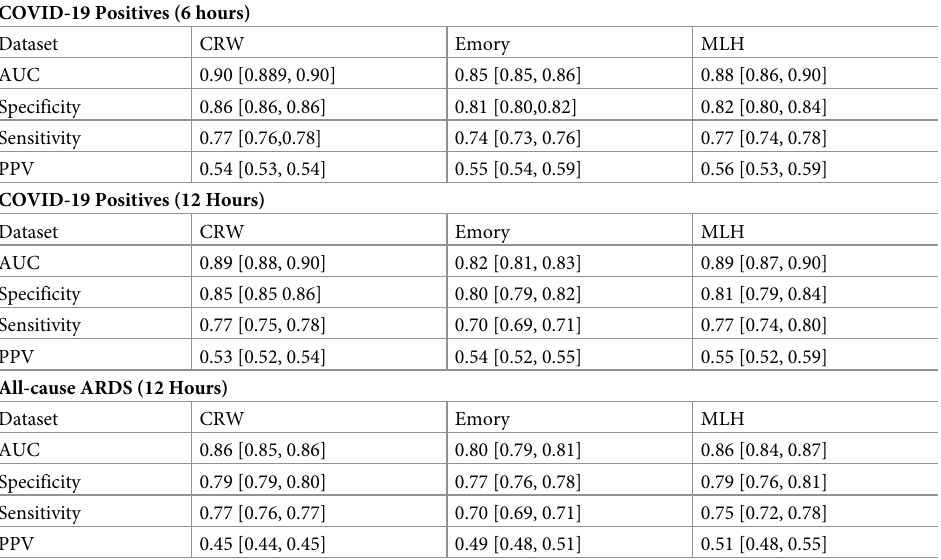
Table 2. Analysis of model performance over 6-hour and 12-hour prediction